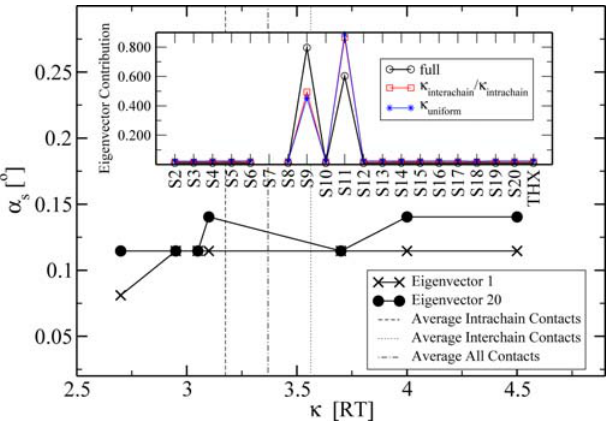
Figure 5. The Angle a s between the Respective Eigenvectors for an Interaction Strength j of Protein S12 and for the Full Parameter Set The broken vertical lines indicate the average values used in the first two validation experiments in the section Sensitivity to Parameters. The full parameter set refers to the one in the Results section under Influence Map, Second-order stabilization revealed by two-protein removal. Inset: Illustration of the deviation in the ~ u 20 eigenvector contributions for the two different average interaction values (shown for the worst case of S7). DOI: